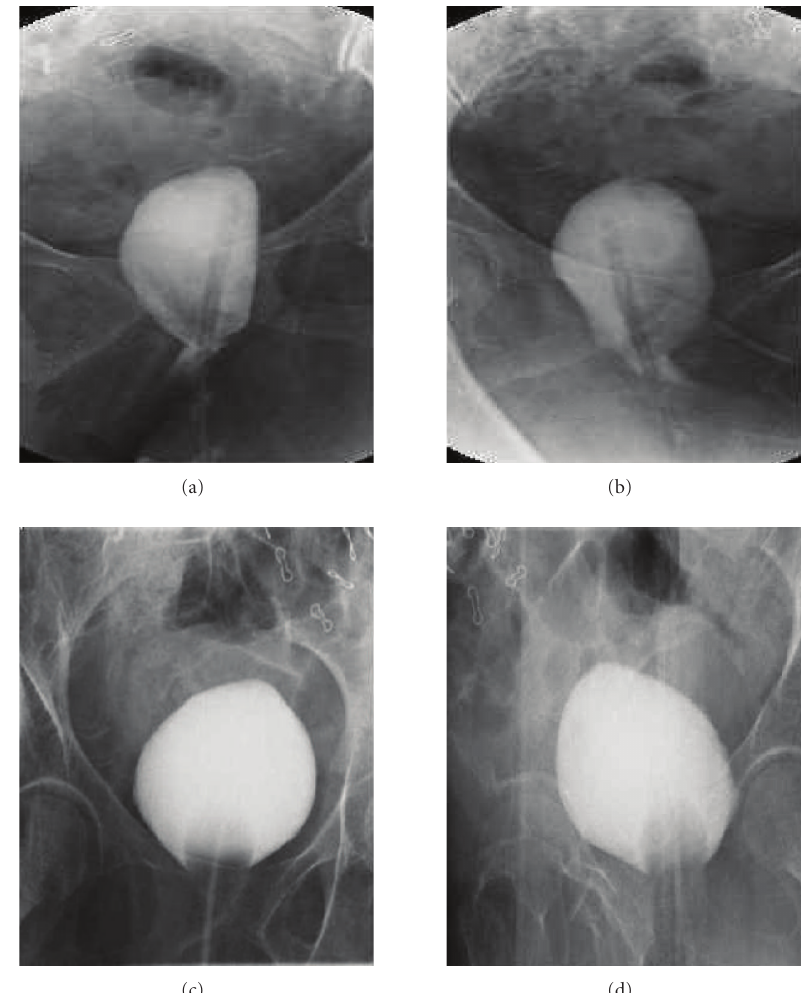
Figure 3: (a), (b) Preoperative ascending cystogram of a patient with G III cystocoele and severe SUI. (c), (d) Postoperative ascending cystogram of the same patient, 6 weeks after Prolift and TVT-O